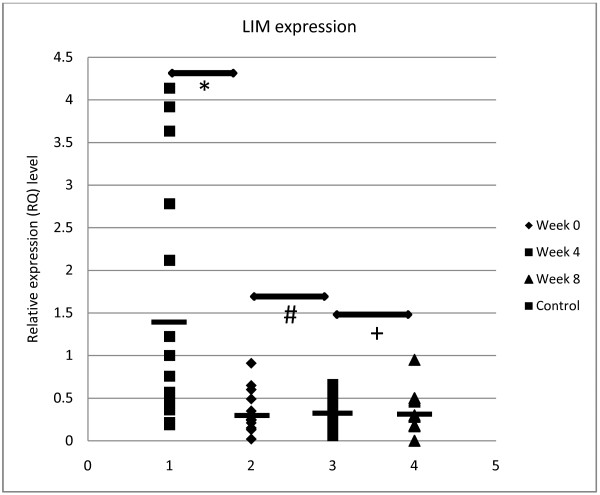
PDLIM5mRNA expression level incontrol subjects and patientsat 0, 4, and8 weeks after olanzapinetreatment. The mean PDLIM5 mRNA expression level was significantly lower in naïve patients than in control subjects (naïve patients: 0.31±0.245; controls: 1.42±1.42; Wilcoxon rank sum test: *p=0.002). After 4 weeks of treatment, no significant changes were detected in PDLIM5 mRNA expression when compared with the mean mRNA level in treatment-naïve patients (after 4 weeks of treatment: 0.36±0.195; Wilcoxon rank sum test: p=0.826). The PDLIM5 mRNA expression level after 8 weeks was 0.36±0.244, with no statistical difference when compared with the mRNA level after 4 weeks of treatment (Wilcoxon rank sum test: p=0.937). The mean PDLIM5 mRNA expression level in controls and patients before and after treatment is indicated by horizontal lines.